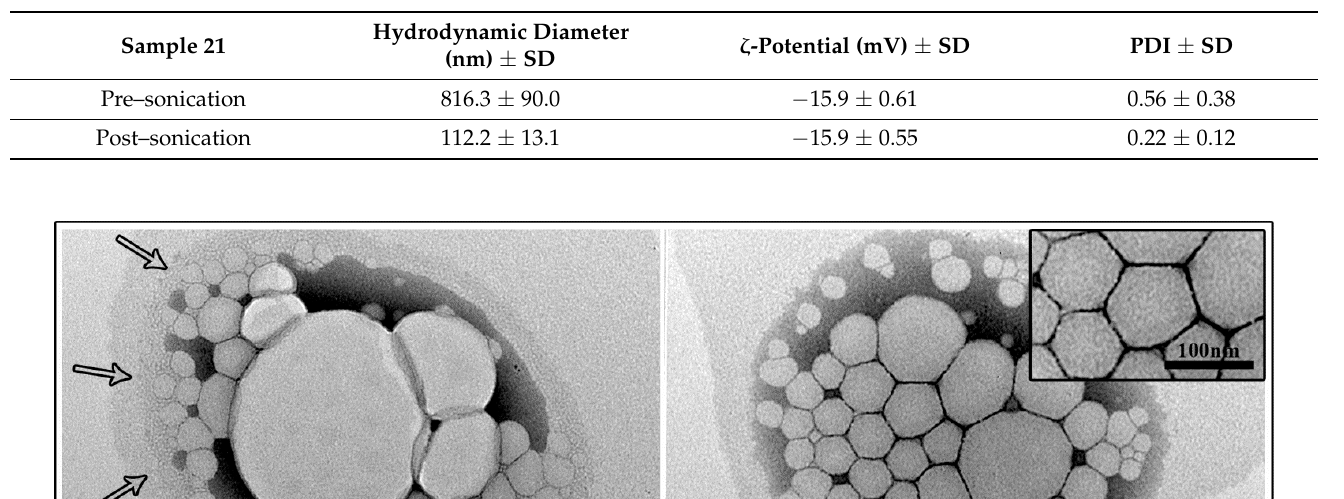
Table 2. Hydrodynamic diameter, ζ -potential, and polydispersity index (PDI) values of sample 21 pre- and post-sonication.